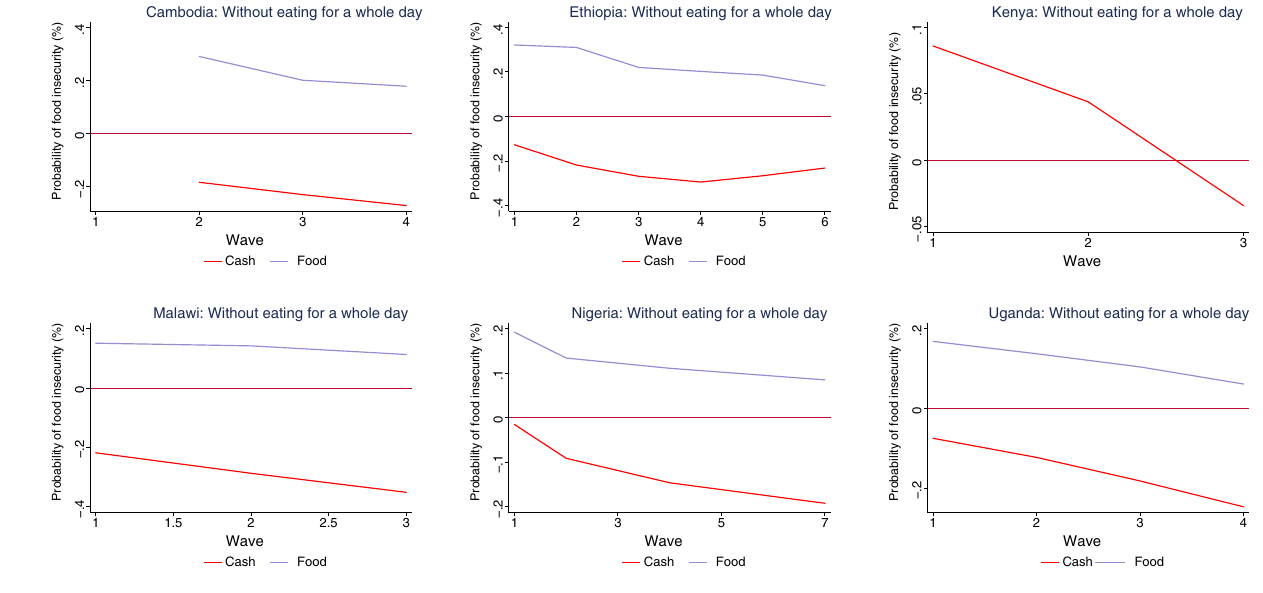
Figure 6. Impact of safety nets on food insecurity (without eating for a whole day) by country.